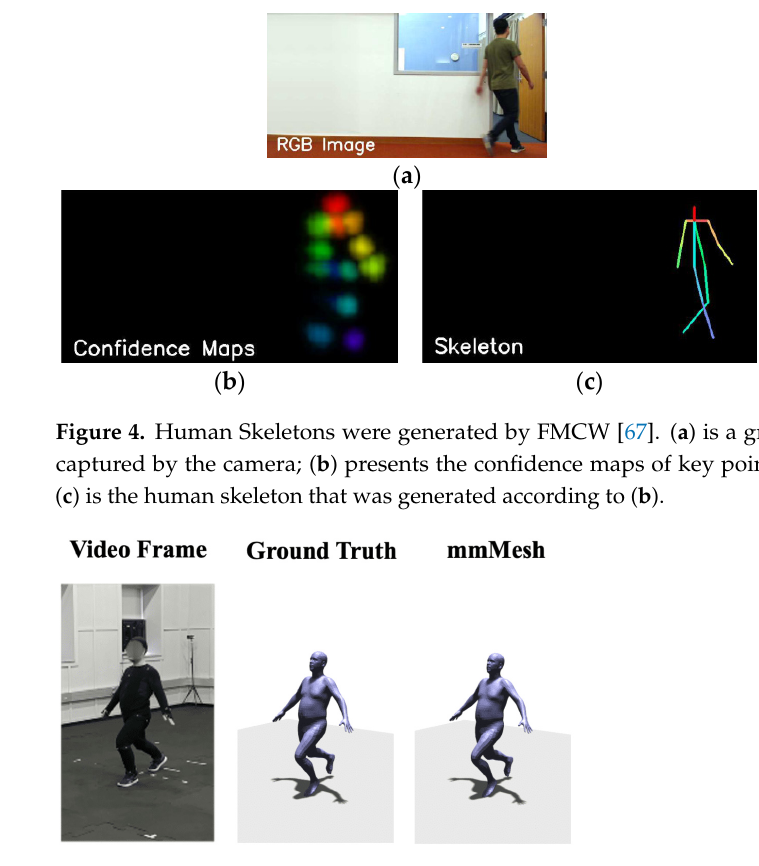
Figure 5. Examples of the constructed 3D human mesh [73]. The images from left to right are the video frames, the ground truth, and the mmMesh predicted human mesh.